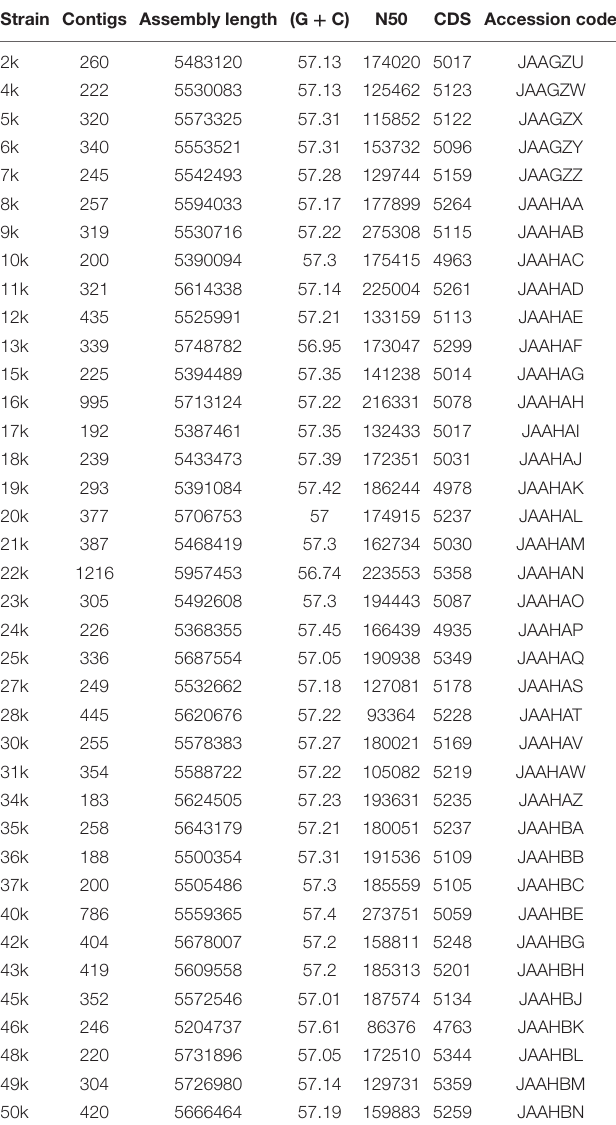
TABLE 2 | Assembly data of K. pneumoniae genomes. Strain Contigs Assembly length (G + C)